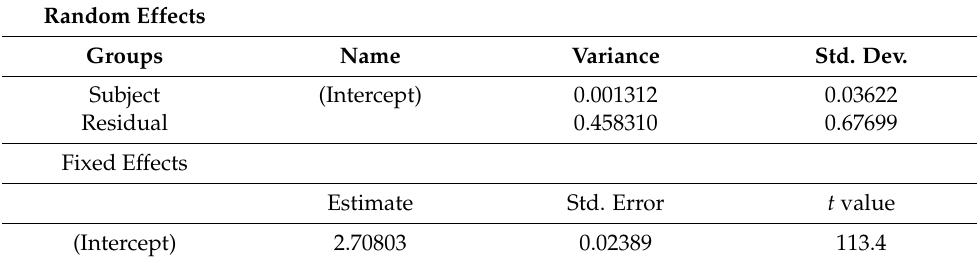
Table 5. The results of the Random Effects